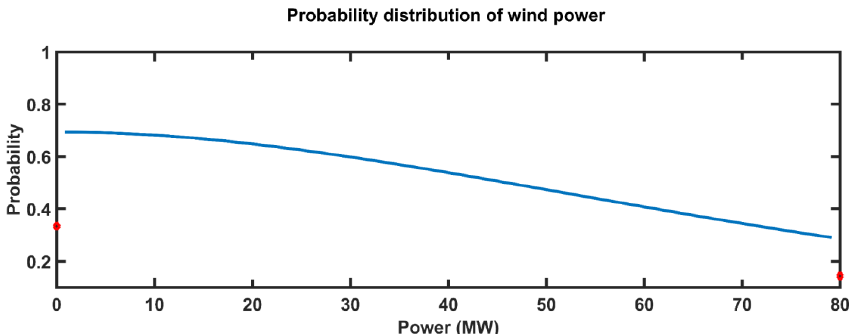
Figure 3. Wind power output mixed probability function.